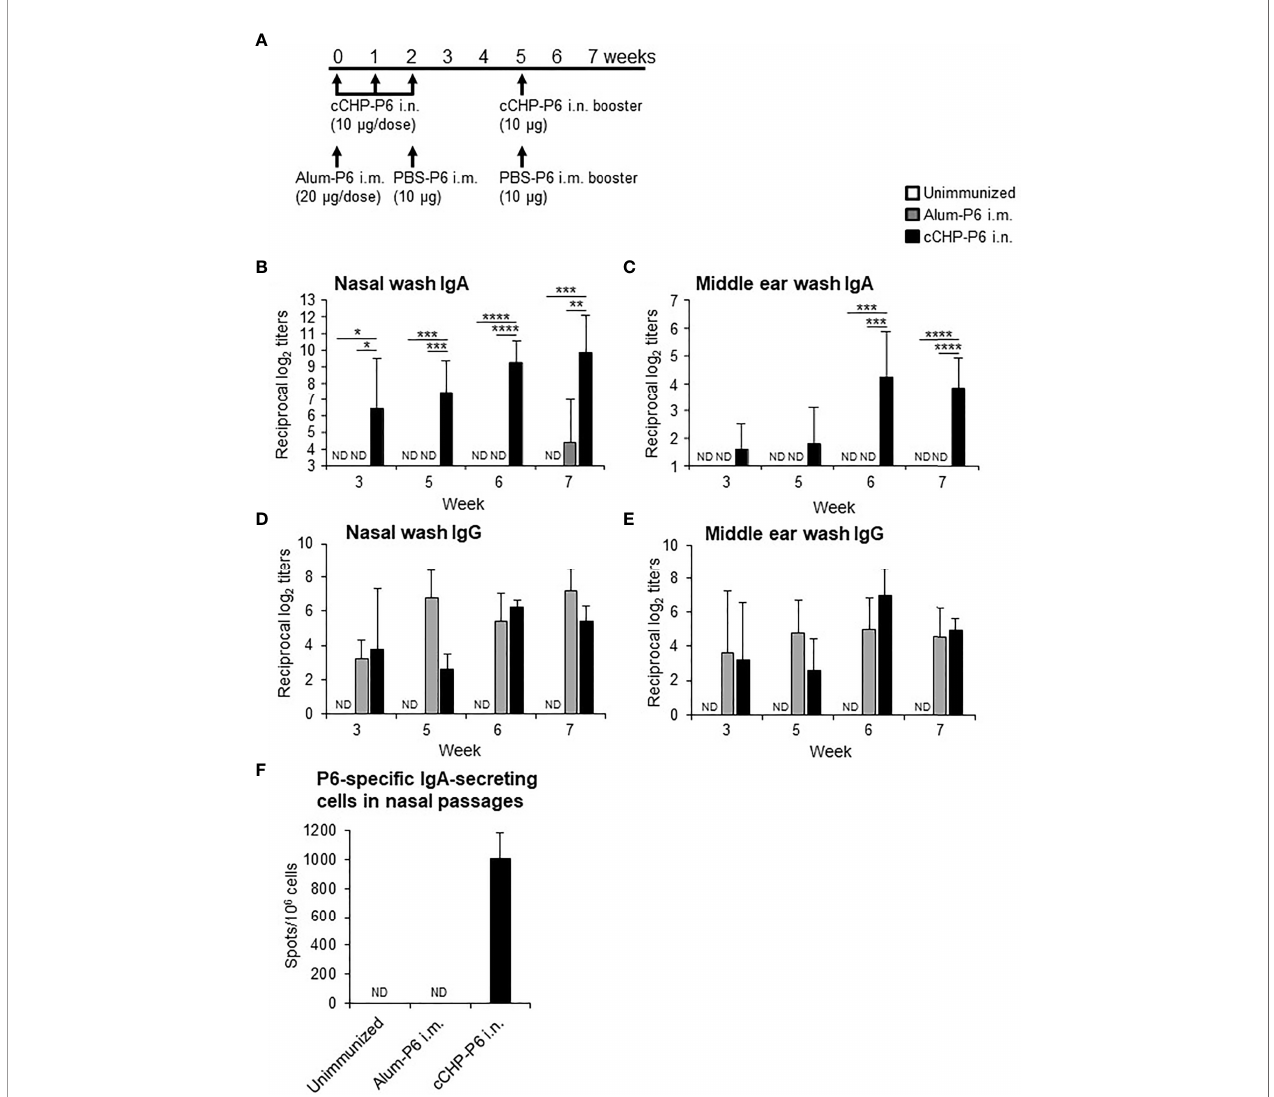
FIGURE 1 | Intranasal immunization with cCHP-P6 nanogel nasal vaccine induces P6-speci fi c antibody responses. (A) Wild-type female BALB/c mice were immunized with four doses of cCHP-P6 nanogel vaccine intranasally (i.n.) or with a single dose of alum-precipitated P6 protein by intramuscular (i.m.) injection, followed by two intramuscular doses of PBS-diluted P6 protein. The control group (unimmunized) received the same volumes of PBS both intranasally and intramuscularly. (B – E) Levels of P6-speci fi c IgA in nasal washes (B) or middle ear washes (C) and P6-speci fi c IgG in nasal washes (D) or middle ear washes (E) for each immunized group (cCHP-P6, Alum-P6, or unimmunized control) were determined by ELISA. (F) Numbers of P6-speci fi c IgA-secreting cells in nasal passages were analyzed by using ELISpot. Data are representative of three independent experiments, and each group consisted of seven mice. ND, not detected in undiluted samples; n.s., not signi fi cant; * P < 0.05; ** P < 0.01; *** P < 0.005; **** P < 0.001, one-way ANOVA with post-hoc Tukey test. Values are means ± 1